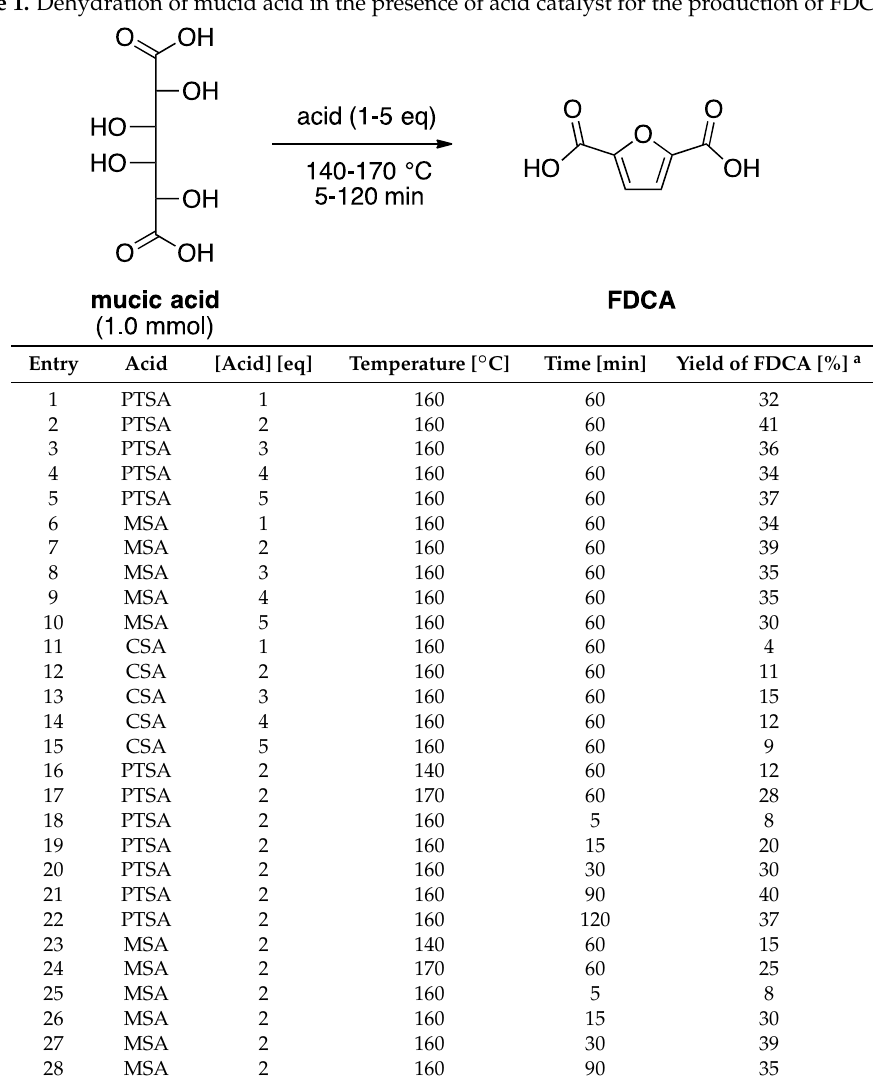
Table 1. Dehydration of mucid acid in the presence of acid catalyst for the production of